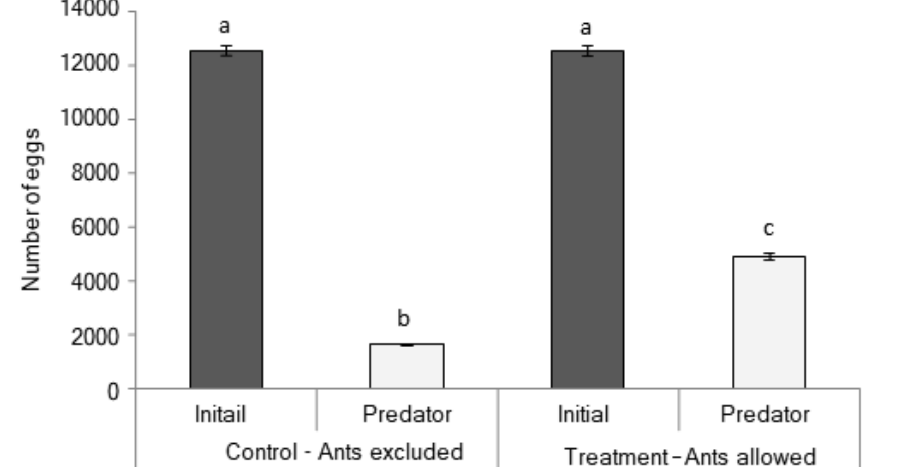
Fig 5. Number of Belenois solilucis eggs available (dark grey) and preyed (light grey) on the control cards (without access to ants) and treatment (with access to ants). The experiment was carried out in 18 locations within the Rashad, Sudan , from February to June 2020 and February to May 2021. Bars represent standard deviation and different letters indicate significant differences ( p < 0.05).